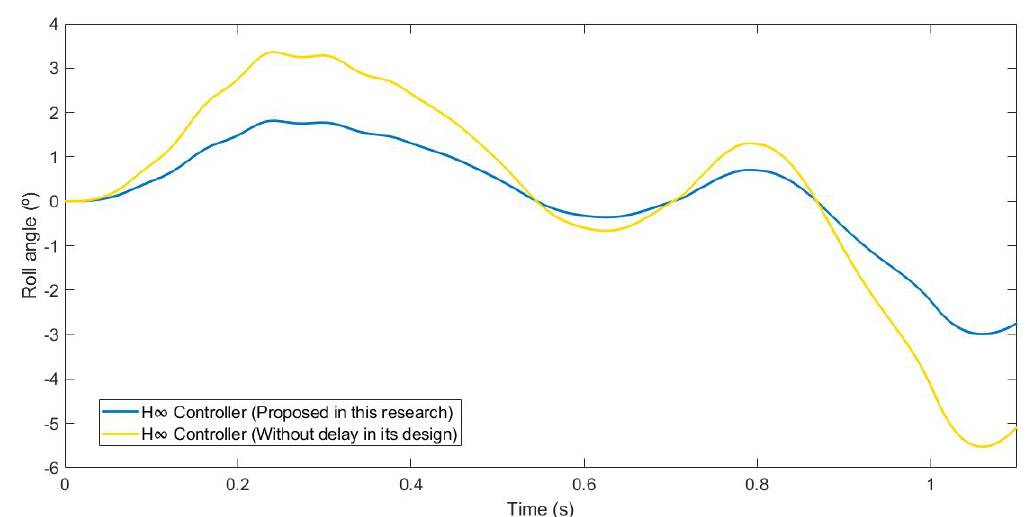
Figure 22. Zoom of the roll angle for test 3: Roundabout at 120